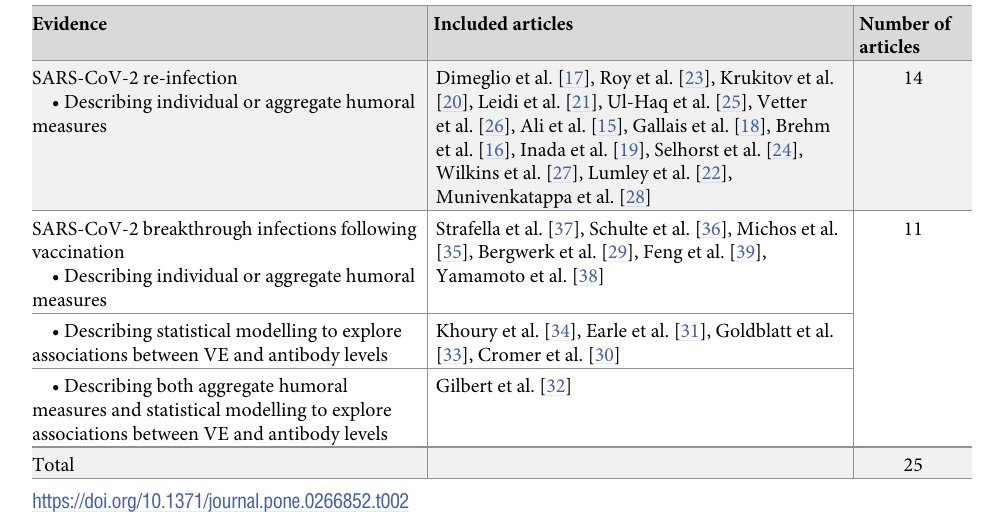
Table 2. Summary of articles included in this review following re-infection and breakthrough infection definition screening, and types of evidence they